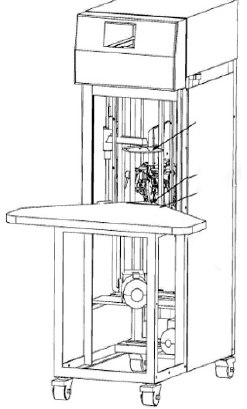
Figure 2. Map inventory machine.